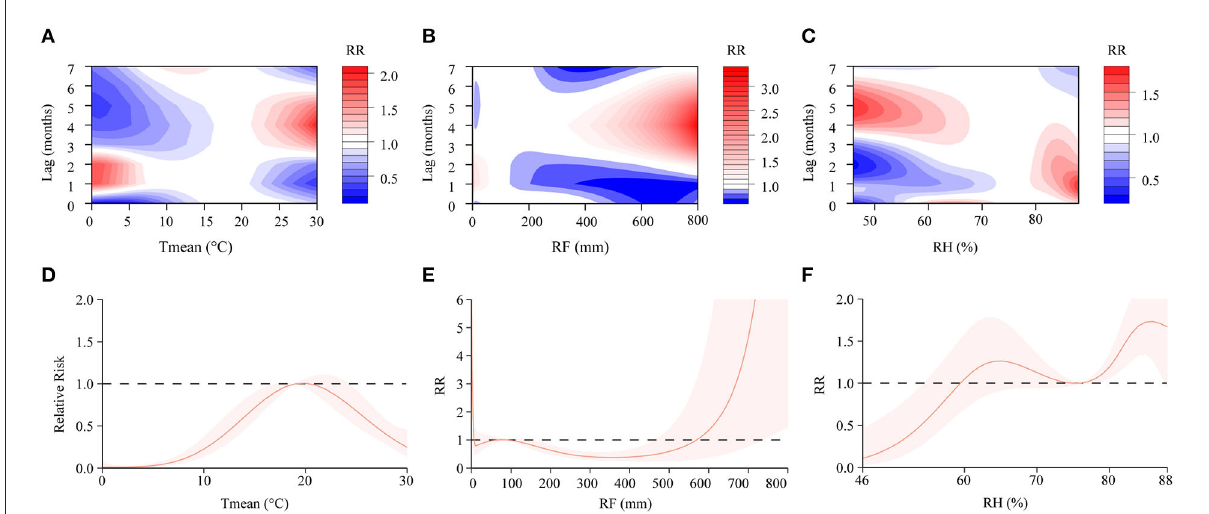
FIGURE7 Contour plots and cumulative exposure-response curves of exposure-response relationships between scrub typhus incidence and three meteorological conditions in the multiple-variable model. (A–C) The y-axis represents the lag period from 0 to 7 months. The x-axis represents the range of observations for each variable. The color gradient represents relative risk (RR). Red represents RR > 1, blue represents RR < 1, and white represents no difference when RR = 1. (D–F) The y-axis represents the RR. The x-axis represents the range of observations for each variable. Mean temperature (Tmean), rainfall (RF), and relative humidity